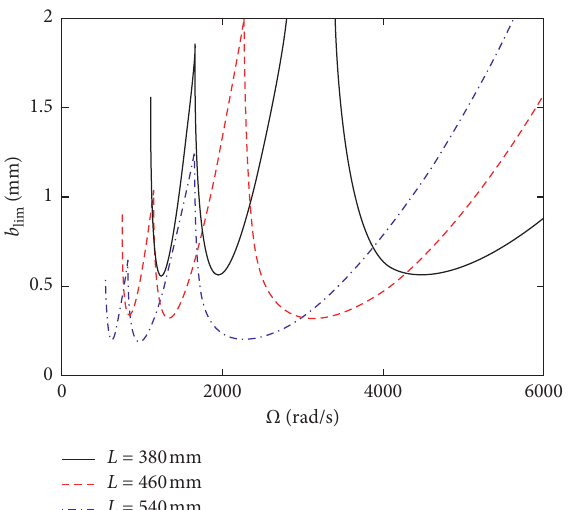
Figure 7: Effect of structural damping.